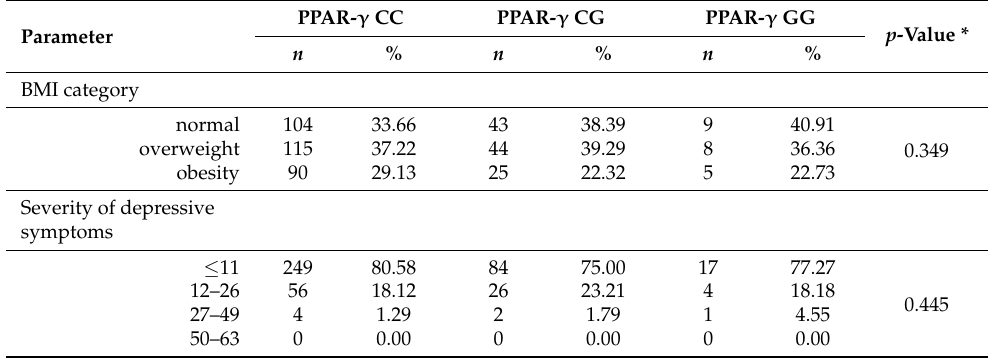
Table 4. Influence of particular genotypes of the PPAR- γ rs1801282 polymorphism on BMI and depressive symptoms.